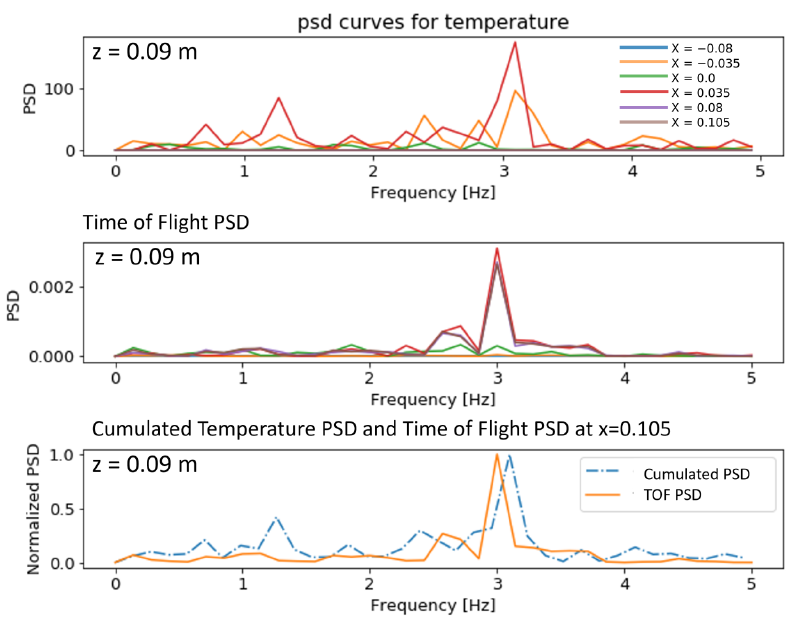
Figure 10. Temperature PSD vs. time-of-flight